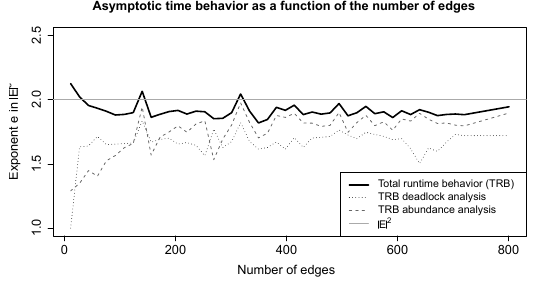
Figure 34. Asymptotic runtime behavior as a function of the number of